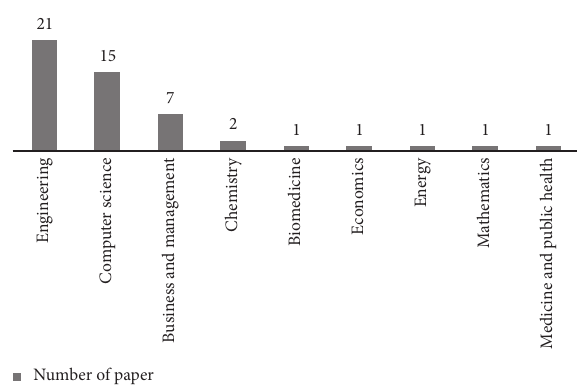
Figure 11: Disciplines of publications with their number of papers.